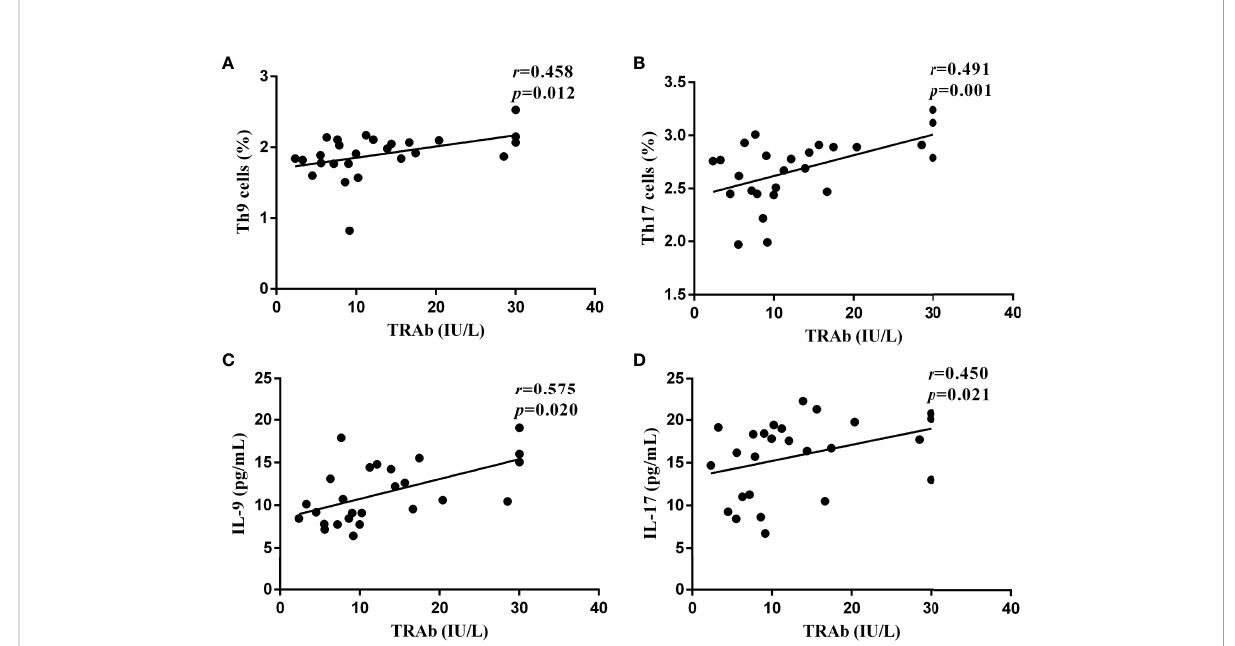
FIGURE 5 The correlations between the serological levels of TRAb and the percentages of Th9 and Th17 lymphocytes and the concentrations of IL-9 and IL-17 in newly diagnosed GD group, represented by (A – D) , respectively. In (A, C, D) , P < 0.05, where in b, P < 0.01. P < 0.05 was considered statistical difference. Represented by (A-D), respectively. In (A, C, D), P <0.05, where in B, P <